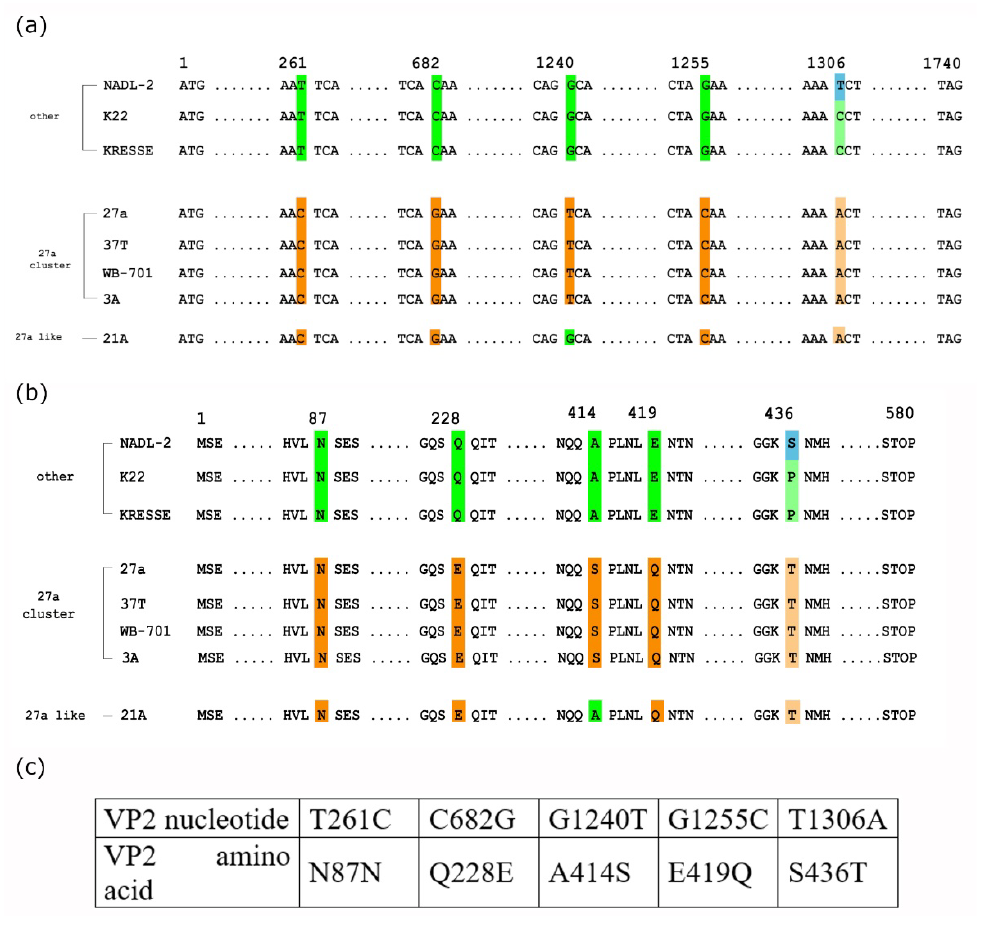
Figure 2. Mutations in the VP2 proteins defining the members of the 27a cluster. Nucleotide ( a ) and amino acid ( b ) differences between members of the 27a cluster and other representative members of the PPV species. Amino acids and nucleotides characteristic to members of 27a cluster are in dark orange; amino acids and nucleotides characteristic to 27a members but occasionally occurring in non-27a members are in light orange. Amino acids and nucleotides characteristic of non-27a members are in green and blue, respectively. PPV isolate (AY684868.1 strain 21A) containing only four 27a characteristic mutations, labelled as 27a-like virus. ( c ) Nucleotide and amino acid mutations characteristic to 27a